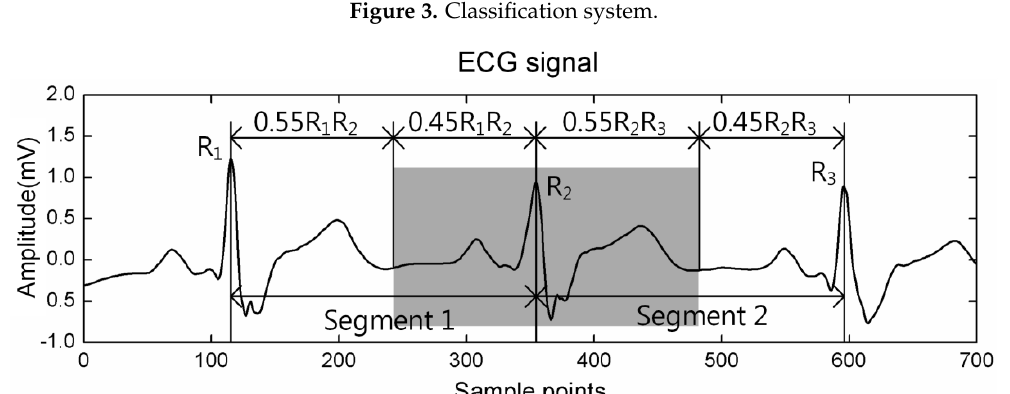
Figure 3 . Classification system. Figure 3. Classification system.